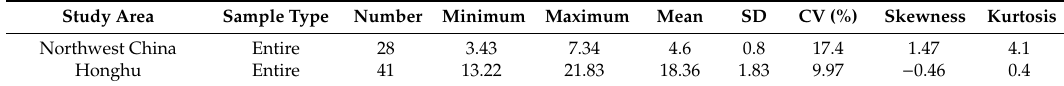
Table 1. Statistical characteristics of soil organic matter.